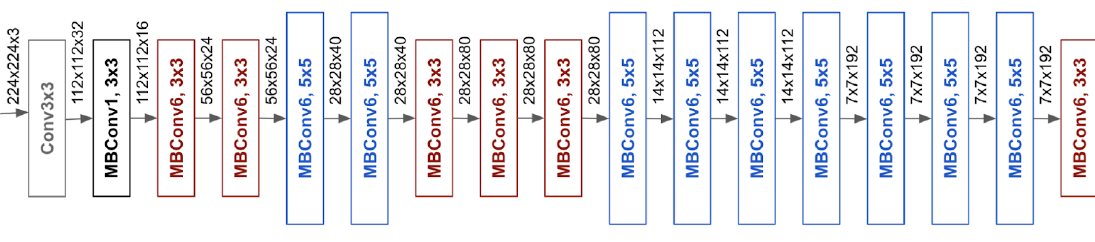
Figure 3. The EfficientNet-B0 architecture as a baseline network